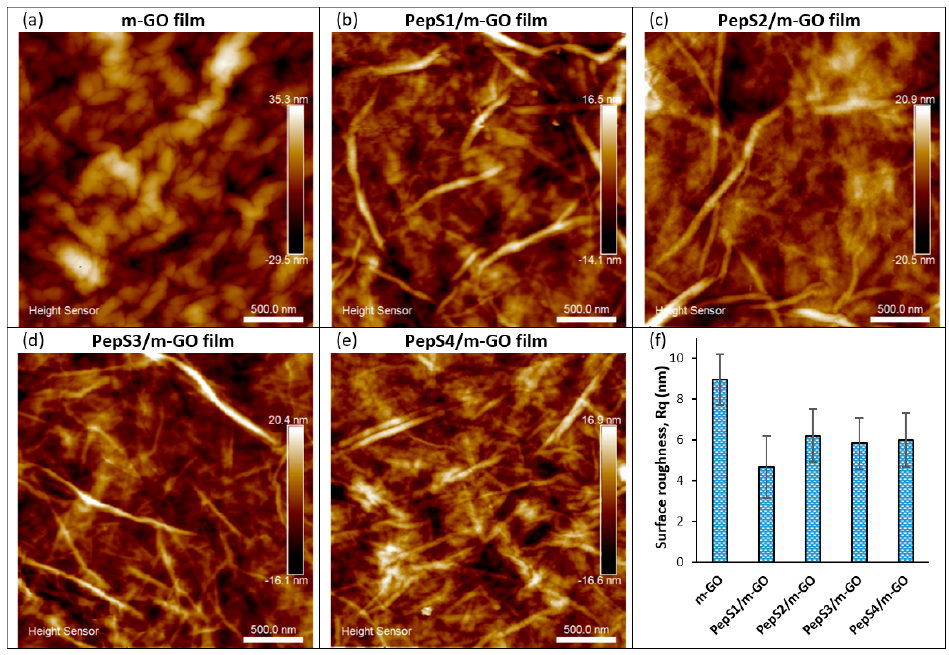
Figure 1. AFM topographic image of m-GO film ( a ) before and ( b – e ) after conjugation with peptide at 2.5 µm × 2.5 µm and corresponding surface roughness measurements ( f ).